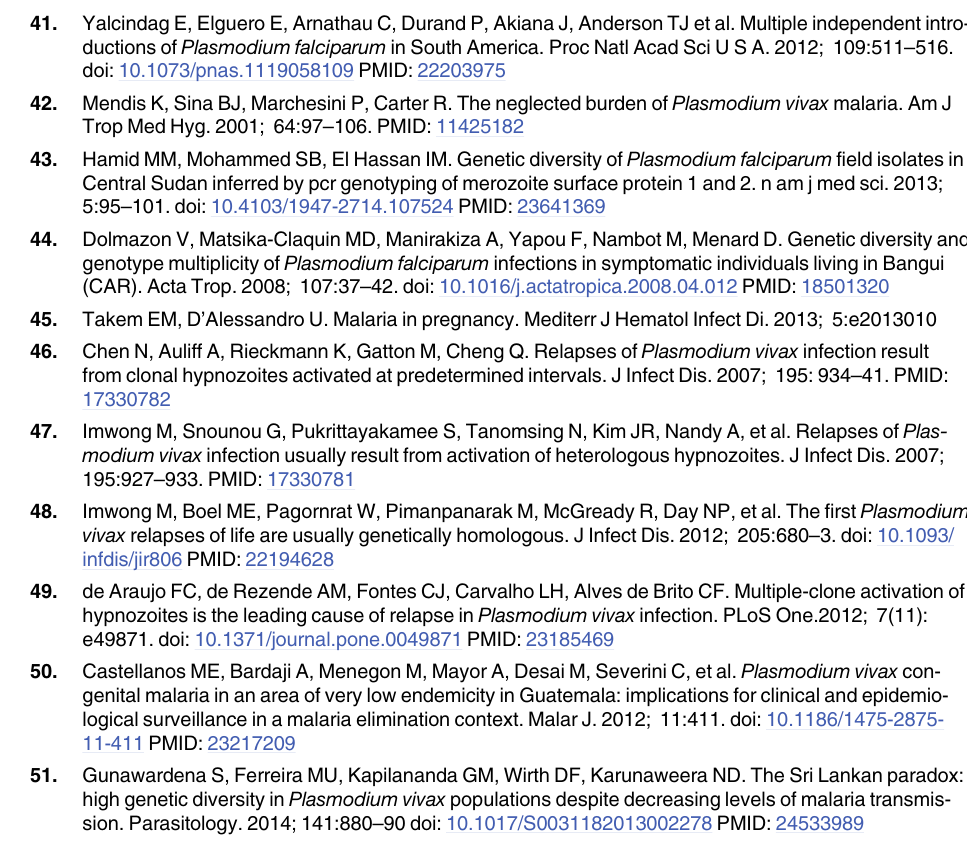
PLOS ONE | DOI:10.1371/journal.pone.0152447 March 24,